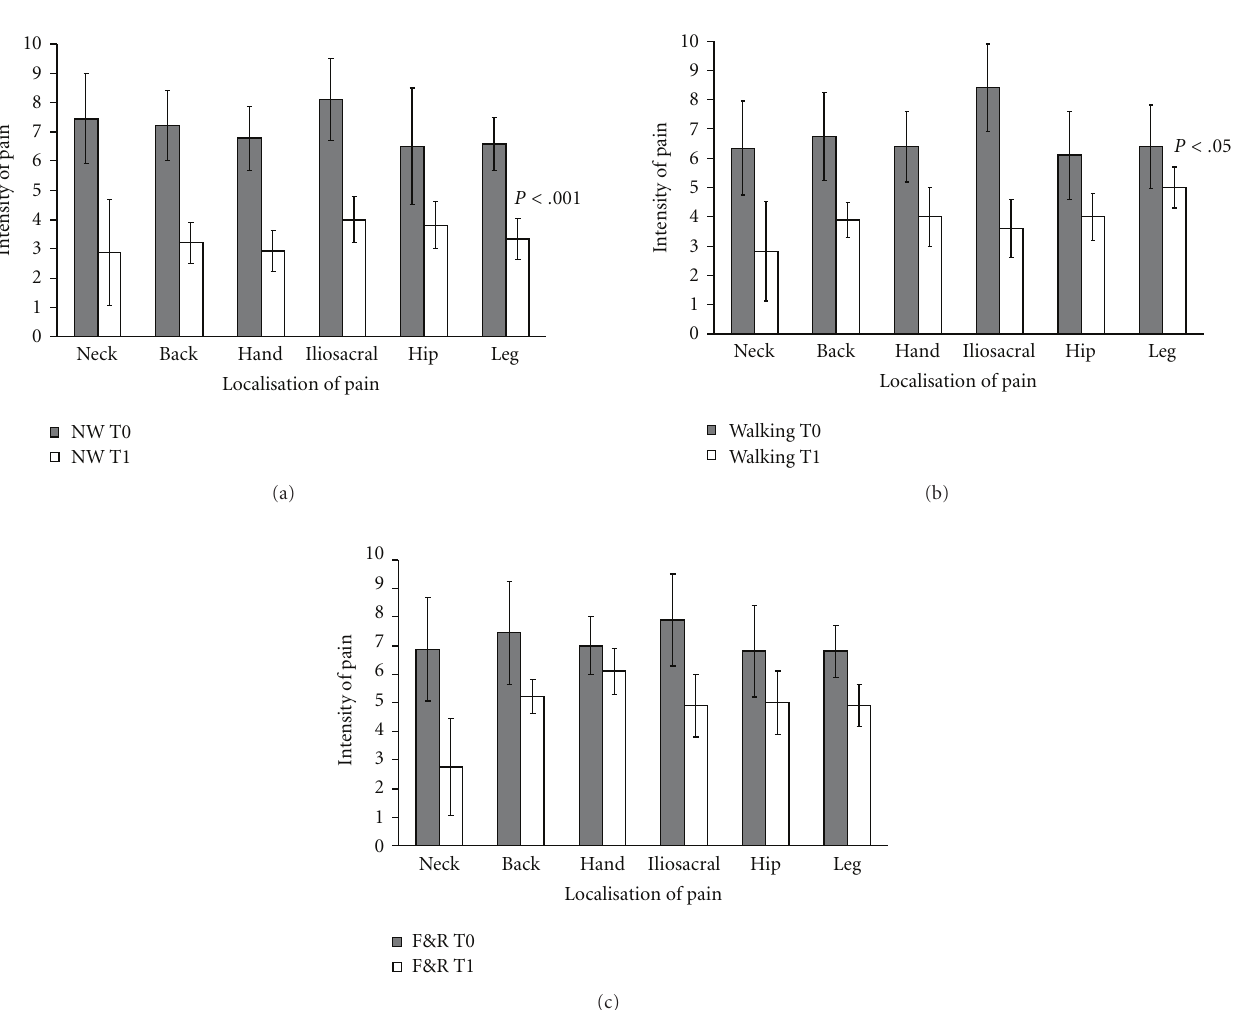
Figure 3: Intensity of pain was significantly lower at the second assessment compared to baseline assessment ( P < . 001). Pain of the back, hands, and legs was more eased by the Nordic walking and walking group. (a) Nordic walking group T0 = first assessment, T1 = second assessment, error bars indicate standard deviations. (b) Intensity of pain in the walking group T0 = first assessment, T1 = second assessment, error bars indicate the standard deviation. (c) Intensity of pain in the flexibility and relaxation group (F&R) T0 = first assessment, T1 = second assessment, error bars indicate standard